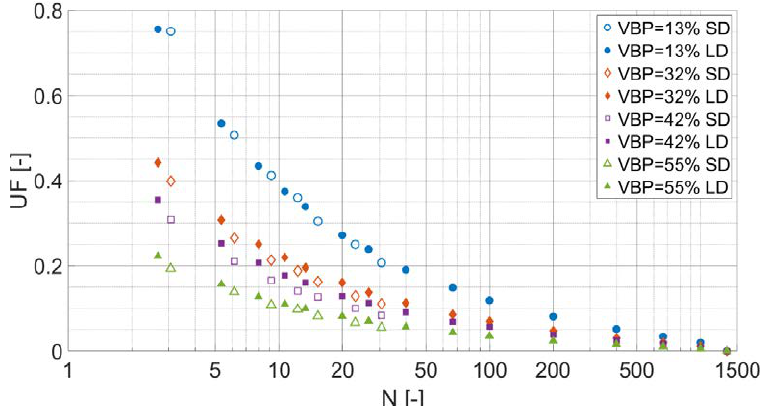
Figure 9. Uncertainty in the VBP estimate from LBPs, when a larger 3D domain is analyzed (SD: small domain, LD: large domain).